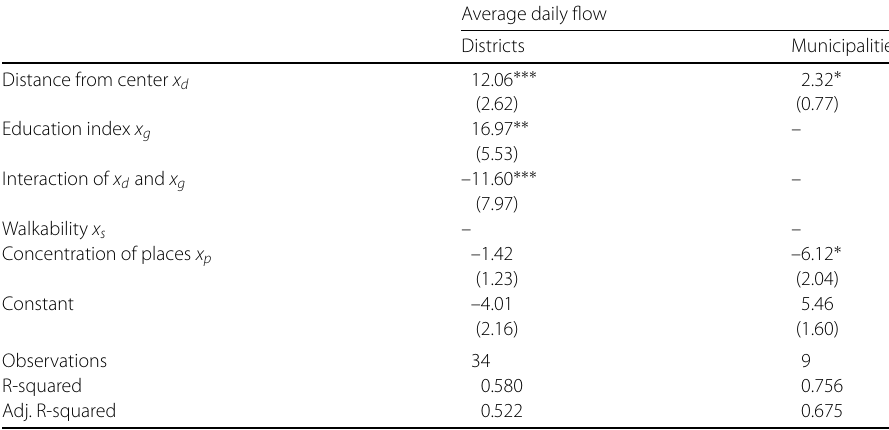
Table 4 Average daily flow regression